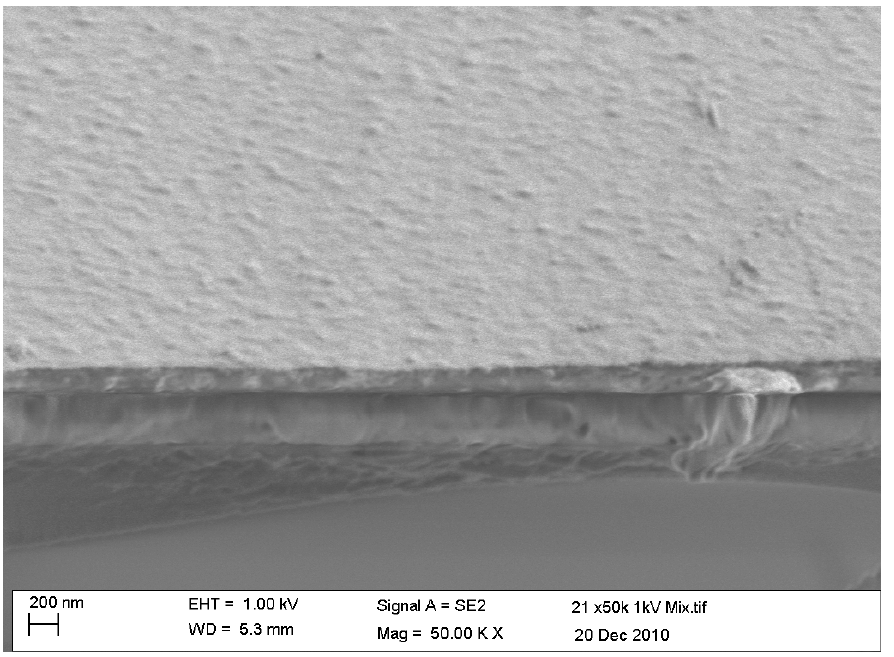
Figure 2. SEM micrograph of fracture section of ( a ) titania sample P4 produced